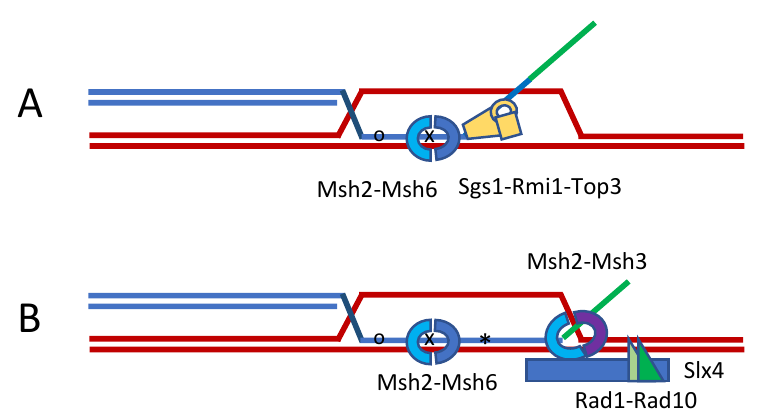
Figure 2. Heteroduplex rejection during strand invasion. The formation of heteroduplex DNA during strand invasion or in SSA will stimulate its unwinding. ( A ) This anti-recombination mechanism is greatly stimulated by the presence of a nonhomologous 3 (cid:48) tail, which attracts Slx4 and Msh2-Msh3 to enhance the tail’s removal by Rad1-Rad10 ( B ). Recognition of the mismatches requires Msh2-Msh6 and is unwound by the 3 (cid:48) to 5 (cid:48) helicase Sgs1 (BLM)-Rmi1-Top3. Heteroduplex rejection does not require MutL homologs, but these are needed to repair the